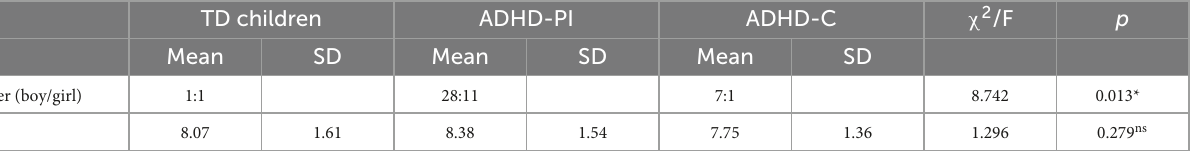
TABLE 1 Demographic information for ADHD children and TD children.